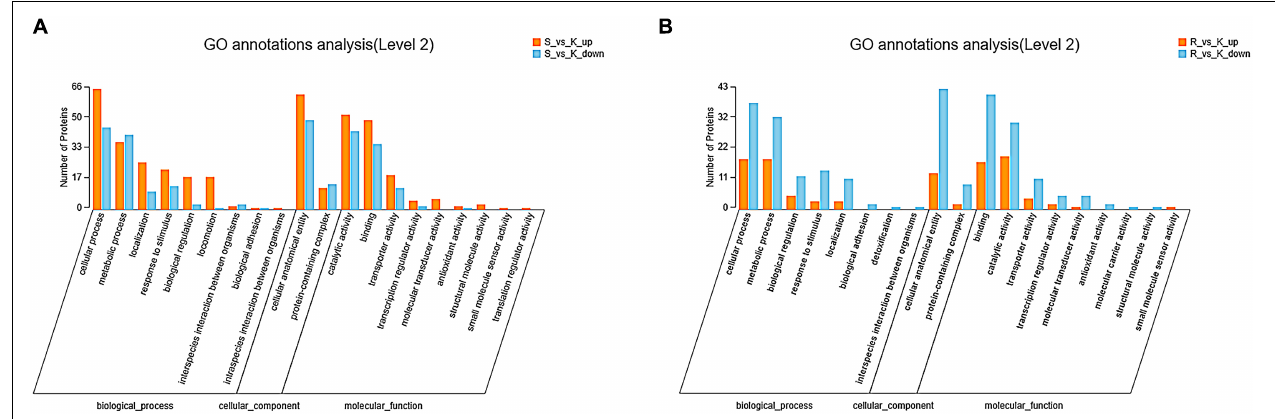
FIGURE 4 | Gene ontology annotation classification map of differentially expressed proteins in the E. coli JW4073(S)/ E. coli K12(K) (A) and E. coli JW4074(R)/ E. coli K12(K) groups (B) .